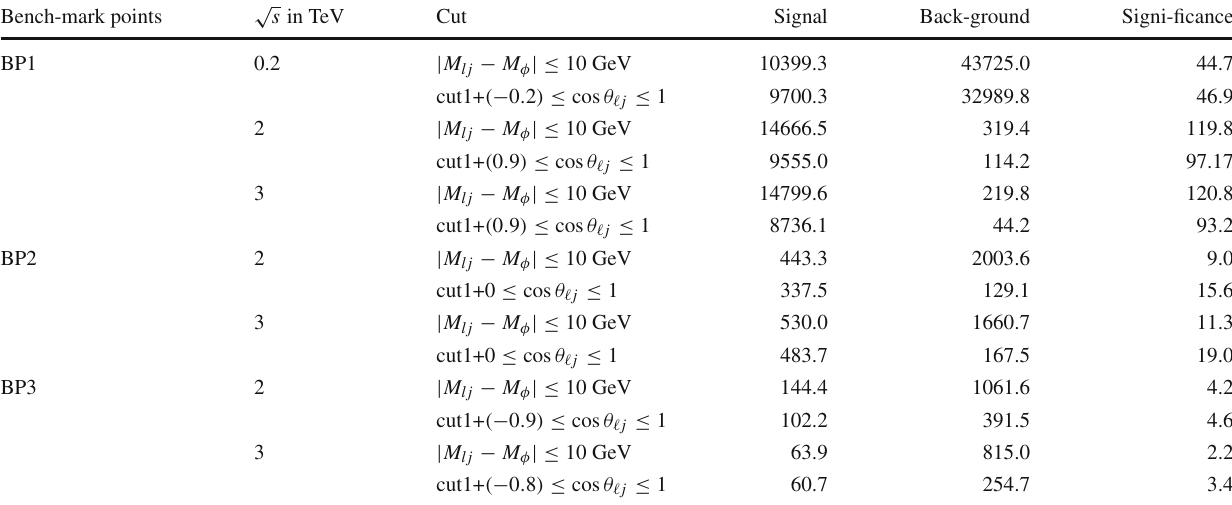
/ 3 ) c with luminosity 100 fb − 1 at e – γ collider 1 μ